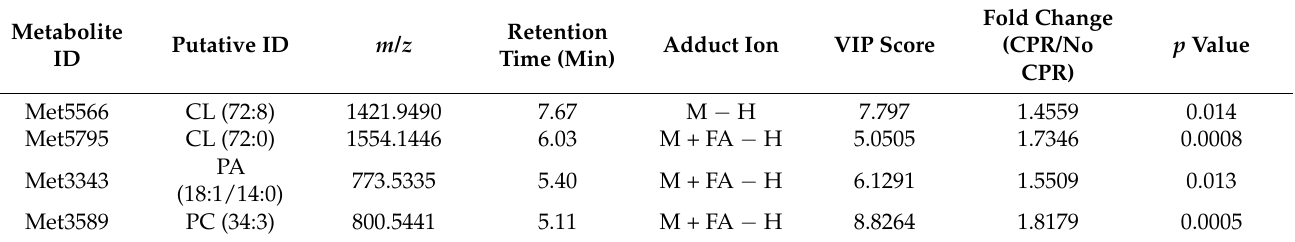
Table 5. The difference of lipidomics in MS-electrospray negative ion mode between deceased donors with or without CPR.